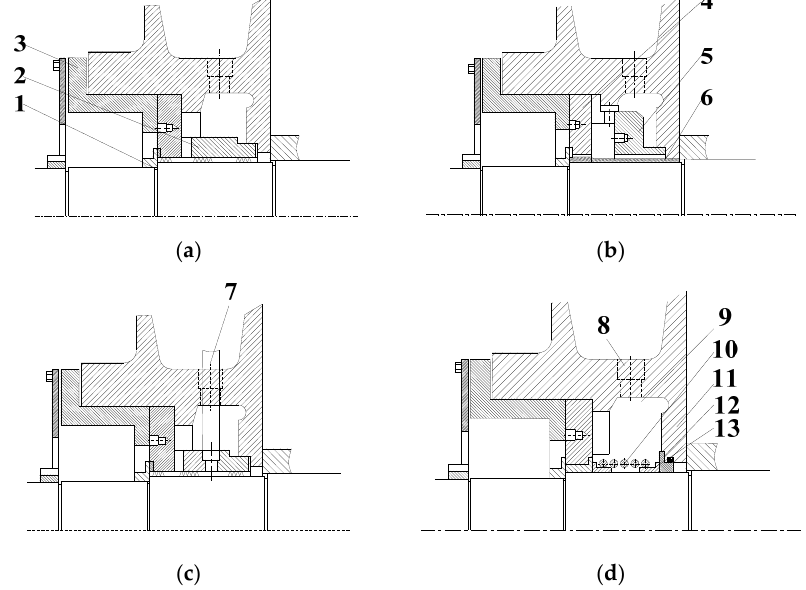
Figure 7. Four seal systems of I-R company in the United States: ( a ) Standard labyrinth